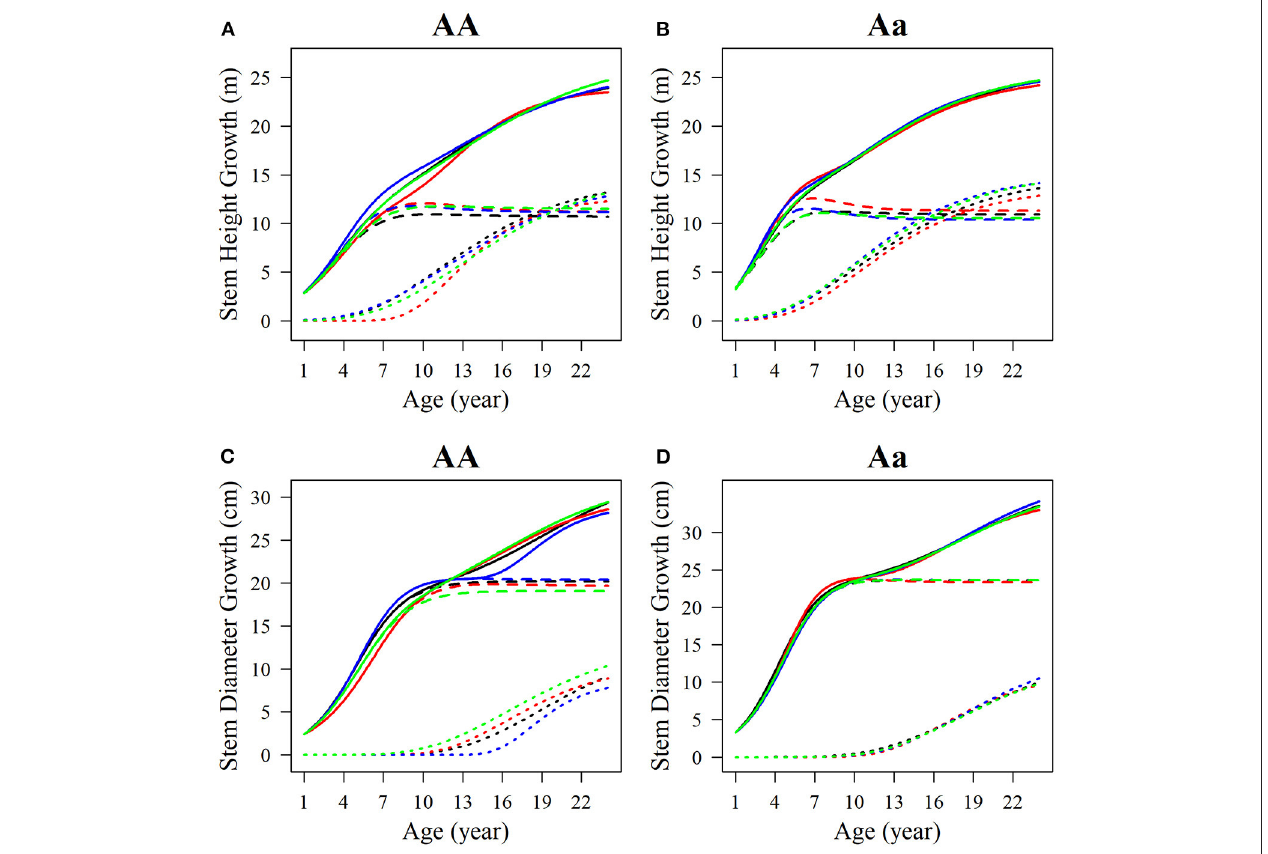
FIGURE 9 | Growth curves of stem (A, B) height and (C, D) diameter of two genotypes with a heritability of 0.1. The overall growth (solid line) for each trait is decomposed into its first phase (broken line) and second phase growth components (dotted line). The sample sizes are 66, 100, and 200. Black represents the real curve, red represents the estimation curve with the sample size of 66, blue represents the estimation curve with the sample size of 100, and the green represents the estimation curve with the sample size of